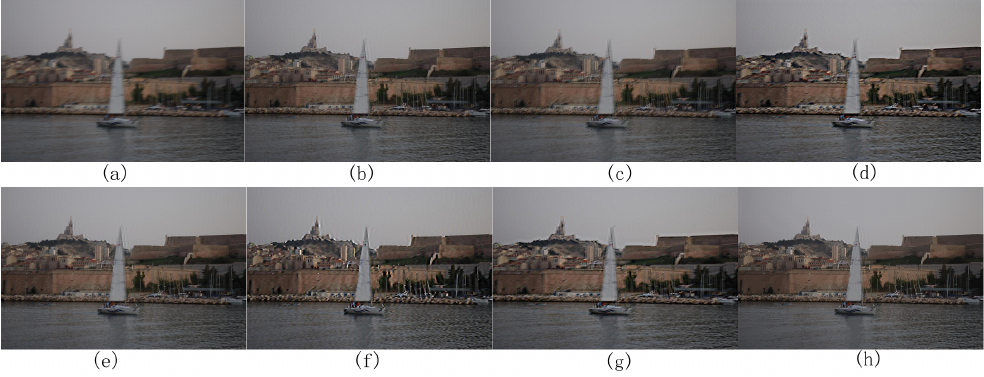
Figure 8. Visual comparison of the results using one challenging image. ( a ) is blurry input and ( b – h ) are generated by [11,14,18,19,21,48] and our proposed method, respectively.